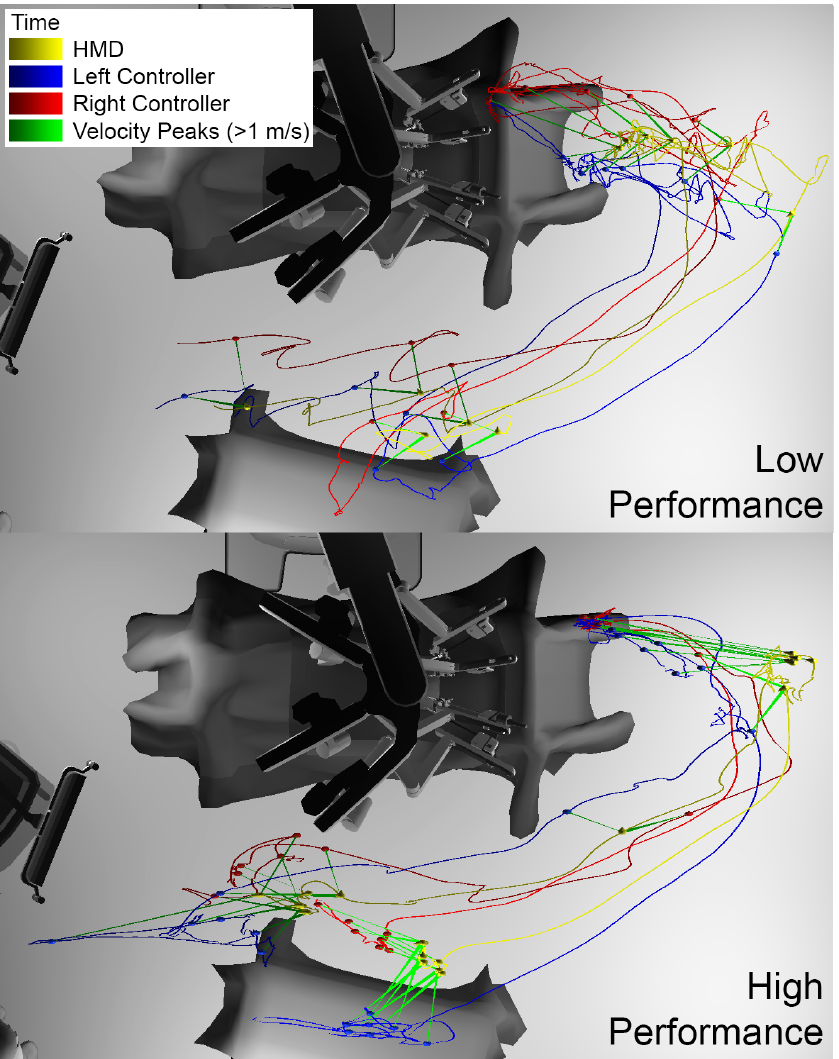
Figure 2. Visualizations of motion data from a low-performance participant and a high-performance participant, based on all three metrics, for the same set of